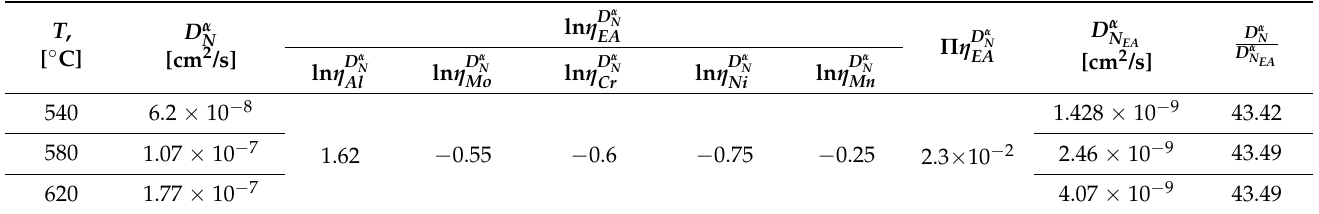
Table 4. The calculation results of the nitrogen diffusion coefficient in the 34CrAlMo5 nitralloy steel α solid solution, at different temperatures.